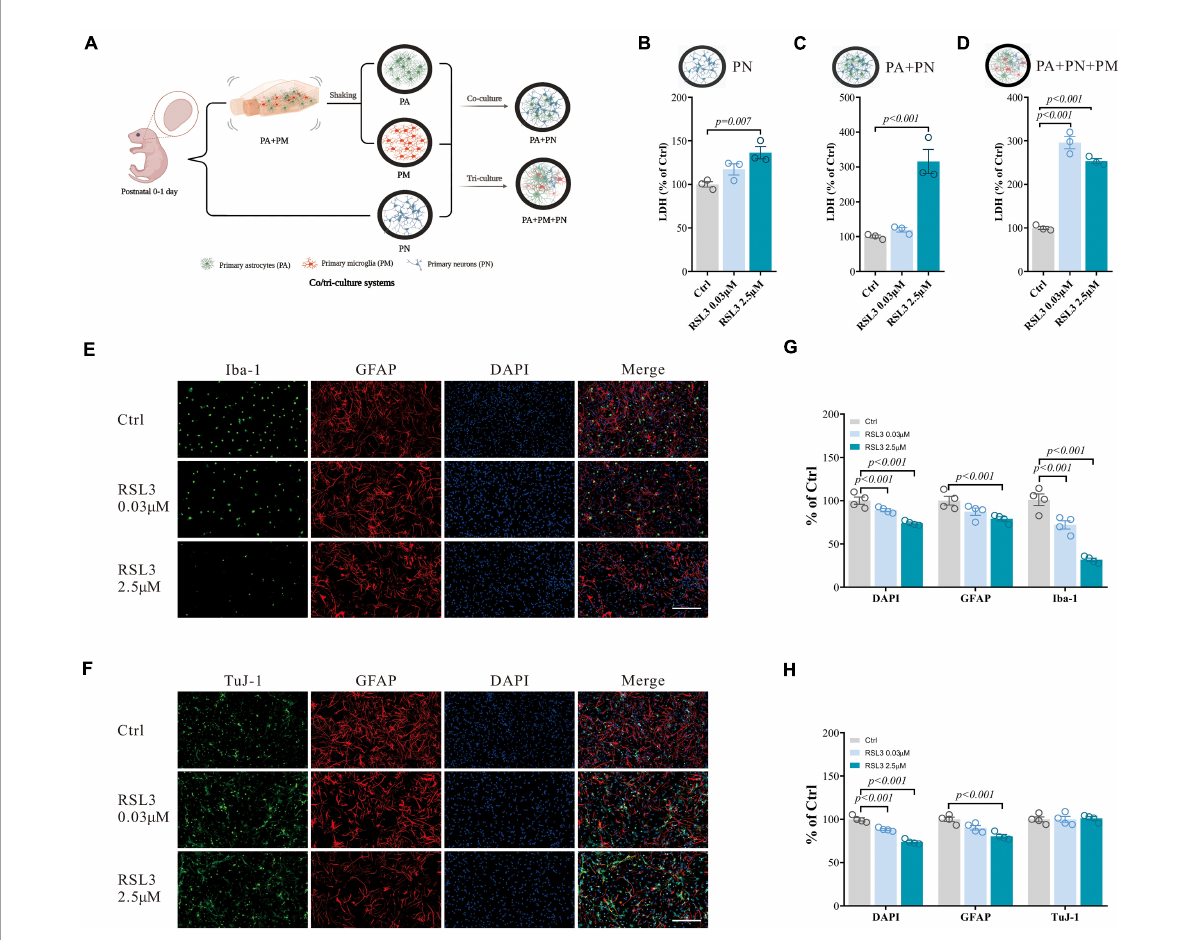
FIGURE4 RSL3 induced primary brain cell death in co/tri-culture system. (A) Workflow for the co/tri-culture system (This image was created by BioRender.com). (B–D) Cell viability detected by LDH in PN monoculture (B) , PA/PN co-culture (C) , and PA/PN/PM tri-culture system (D) after RSL3 treatment for 24 h. (E,F) Brain cells in the tri-culture system were stained with Iba-1 (green), TuJ-1 (green), GFAP (red) and DAPI (blue) after RSL3 treatment for 24 h. (G,H) The quantification of the proportion of DAPI, GFAP, Iba-1, and TuJ-1 positive primary brain cells in the tri-culture system. Data are means ± SEM, N = 4, scale bar = 200 µ m. One-way ANOVA with post hoc Tukey test was